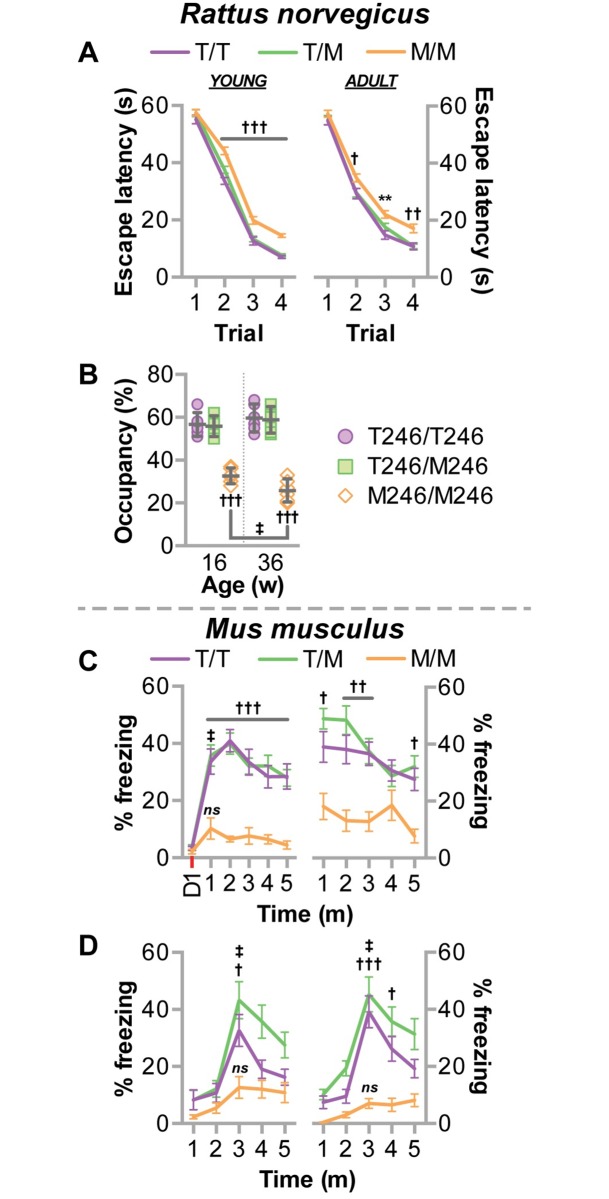
CHIP-T246M rodents developed cognitive deficits.In rats, (A) the average latency to find the platform over four consecutive training days in the Morris Water maze task is represented by line plot and summarized by the mean ± SEM. (B) The amount of time spent in the target quadrant when the platform was removed after the last trial is represented by dot plot and summarized by the mean ± 95% CI. Tests A-B were administered on rats with the indicated genotypes at 16 w of age (young) and repeated at 36 w of age (adult), N = 6 animals/genotype, Tukey’s post hoc test: ** corresponds to p < 0.01 comparing M/M vs. T/T; †, ††, ††† correspond to p < 0.05, 0.01, 0.001 comparing M/M to T/T and T/M; ‡ corresponds to p < 0.05 within genotype. Conditioned fear testing was measured in mice by calculating the percentage of time freezing (no movement) during either (C) context or (D) cue-dependent learning during the training day (D1), and over 5 minute periods either a day after training (left) or two weeks later (right). Tests C-D are represented by line plot and summarized by the mean ± SEM (N = 10–20 animals/genotype), Tukey’s post hoc test: †, ††, ††† correspond to p < 0.05, 0.01, 0.001 comparing M/M to T/T and T/M; ‡ corresponds to p < 0.001 compared to the initial stimulus within the genotype (learning), ns = p > 0.05.